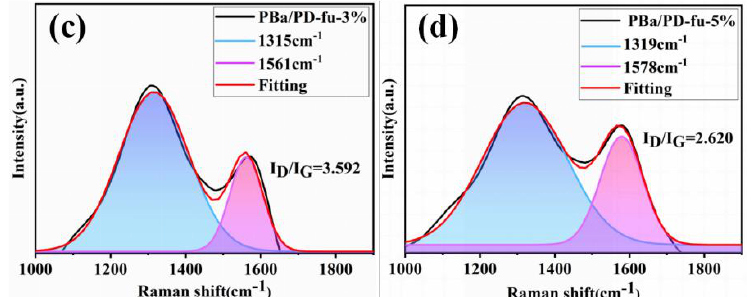
Figure 9. Raman spectra of charred residue of ( a ) PBa, ( b ) PBa/PD − fu − 1%, ( c ) PBa/PD − fu − 3%, and ( d ) PBa/PD − fu − 5% after the CONE test.